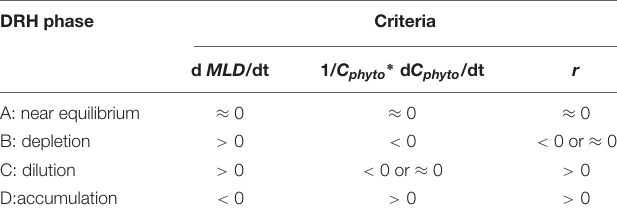
TABLE 1 | Summary of the criteria used to identify the phytoplankton seasonal phenology characteristics described by the Disturbance Recovery Hypothesis (DRH) based on temporal variations of mixed layer depth MLD (entrainment versus shoaling), mixed layer phytoplankton biomass C phyto , and specific net phytoplankton accumulation rate r from Eq. 4 and